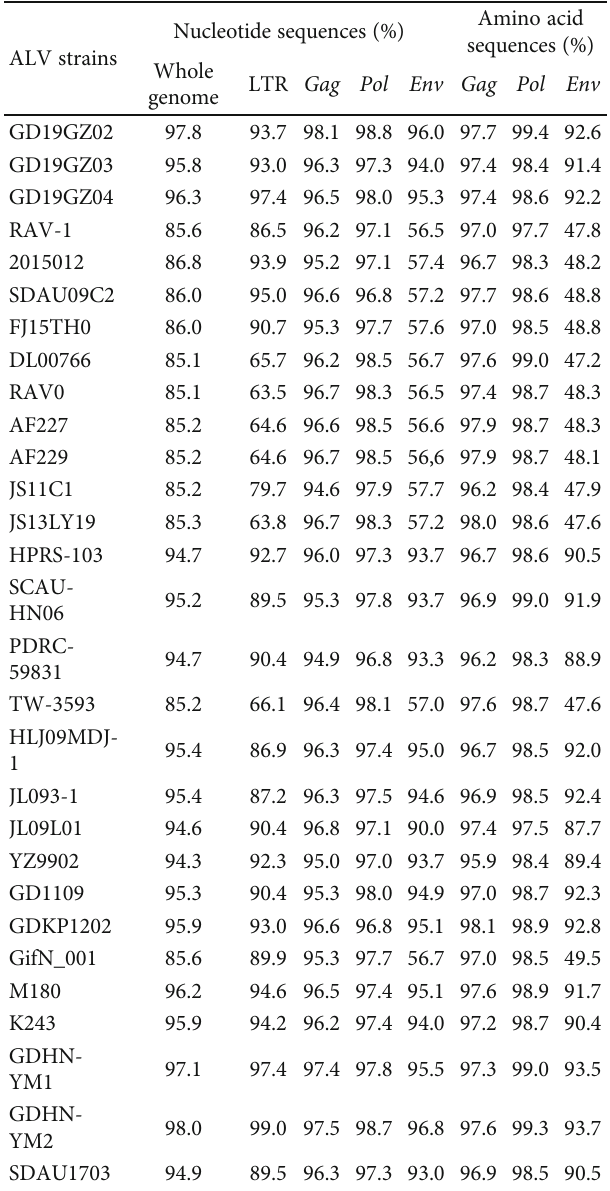
Table 4: The nucleotide and amino acid identity shared between GD19GZ01 and the other reference